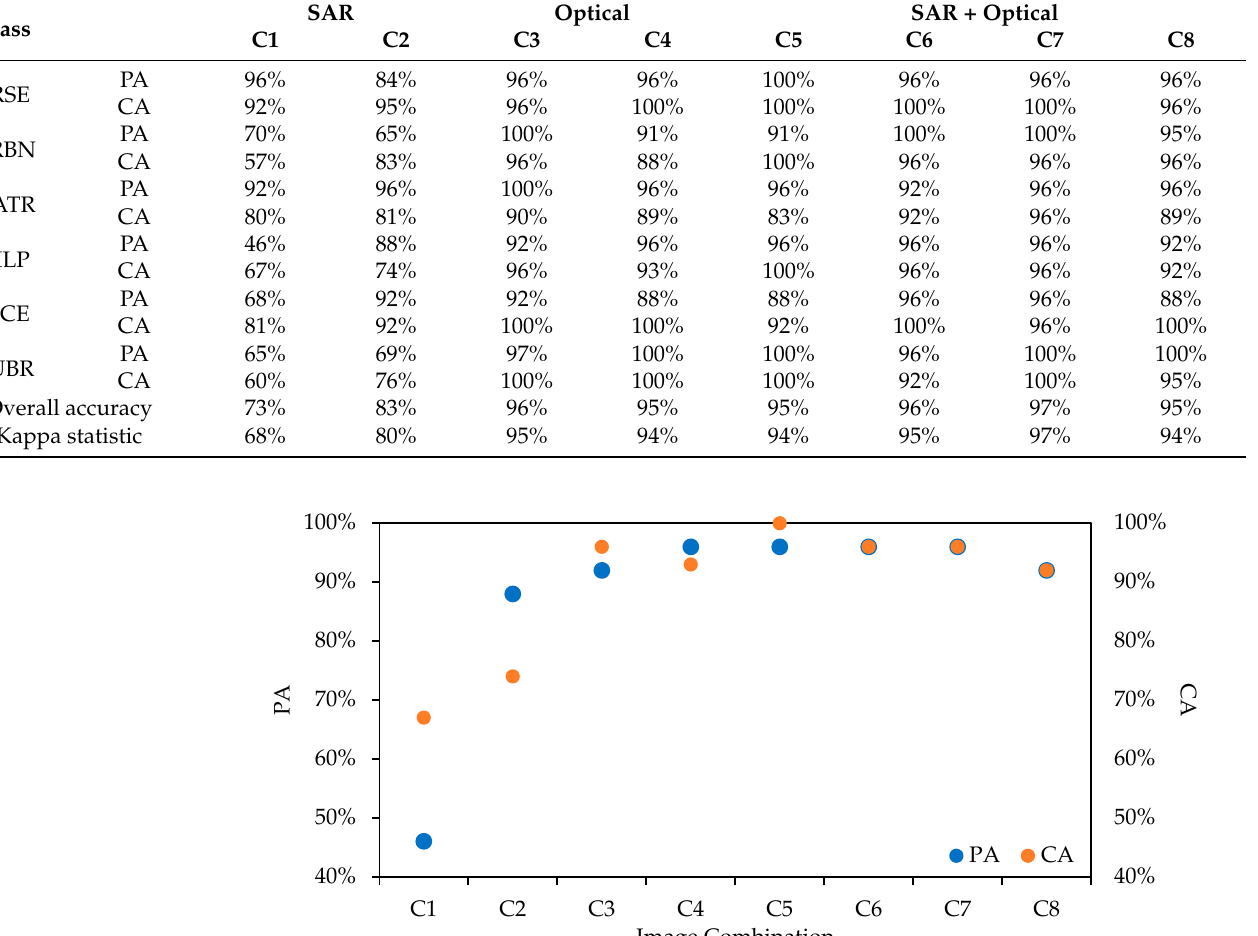
Table 4. Accuracy assessment of land use–land cover classification in 2020.